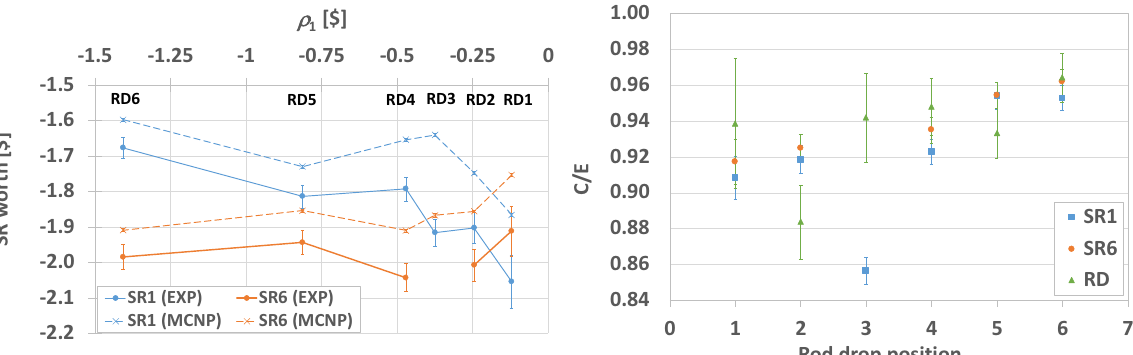
Figure 4. Left: Experimental and calculated SR worth as a function of the reference sub-critical configuration reactivity (SR6 + RD3 was not measured yet, this point will be added in an update). Right: Ratio of MCNP calculated values and measured values for SR1, SR6 and rod